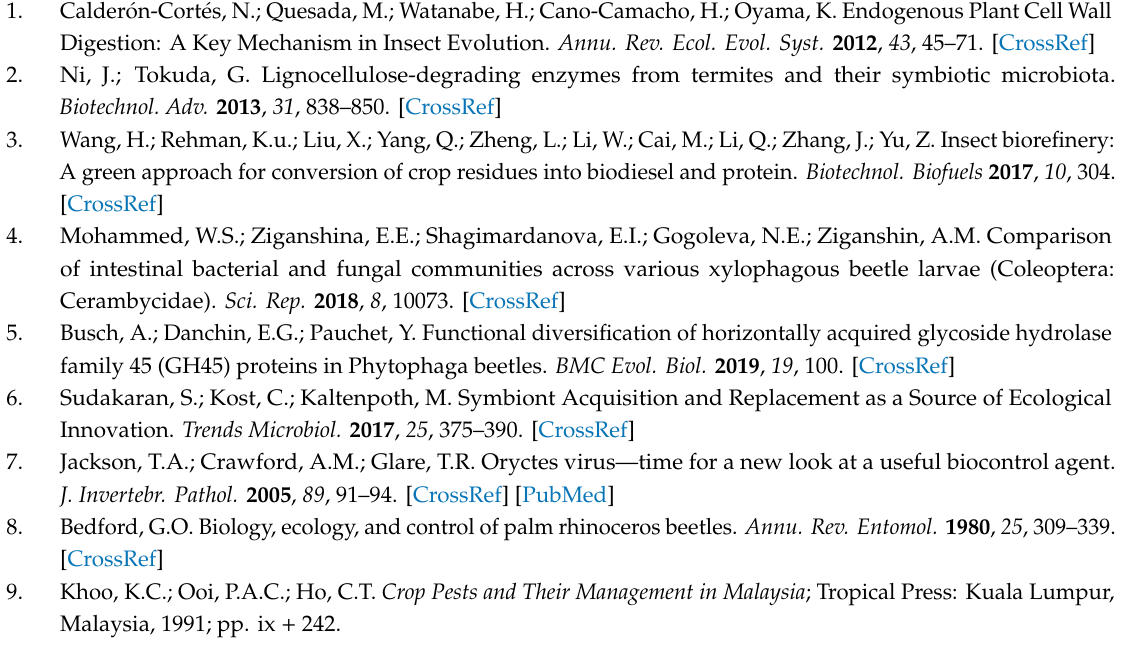
Figure S1: Phylogenetic tree based on 18S rRNA sequence analysis, Figure S2: Phylogenetic tree based on ITS1-5.8S-ITS2 region sequence analysis, Figure S3: Alpha rarefaction curve for metabarcoding using Faith’s PD metric, confirming plateaus were reached at our sequencing depth of 1553 for all samples, Data Sheet S1: Results of the Oryctes rhinoceros metabarcoding study, Table S1: Primers used to identify cultured